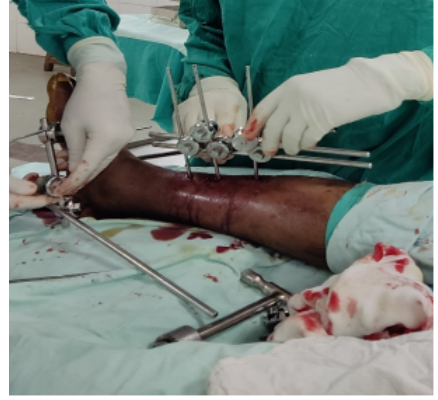
Figure 2. frame assembly